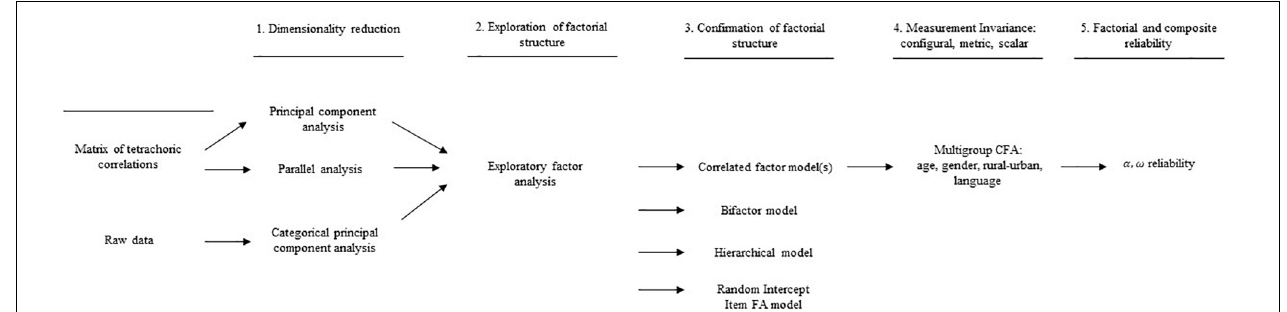
FIGURE 1 | Psychometric properties of MCSDS – Form C analysis